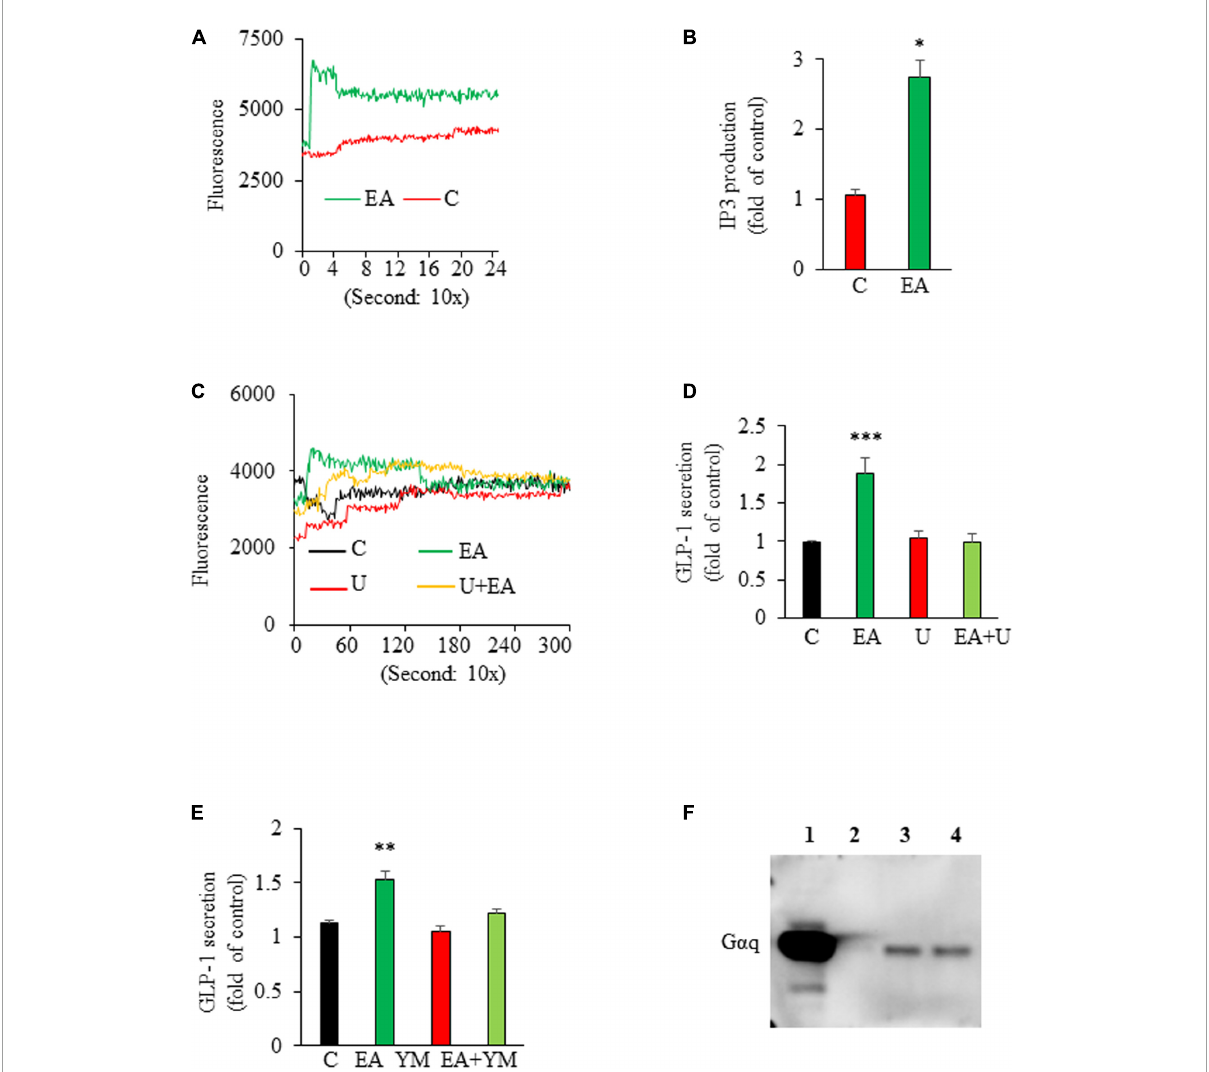
FIGURE2 Elenolic acid (EA)-induced glucagon-like peptide-1 (GLP-1) secretion is mediated via a G α q-PLC-IP3-Ca 2 + -dependent mechanism. (A) GLUTag L-cells were pretreated with Fluo-4AM and treated with vehicle or 10 µ M EA. The [Ca 2 + ] i response was measured using a fluorescence plate reader. A representative graph from 4 experiments is shown. (B) L-cells were treated with 10 µ M EA or vehicle for 20 s. The intracellular IP 3 contents were measured using an ELISA kit. (C) GLUTag cells were labeled with Fluo-4 AM in the presence or absence of 10 µ M U73122 (U) for 30 min, followed by an injection of 10 µ M EA or vehicle. The [Ca 2 + ] i response was measured as stated above. (D) GLUTag cells were pretreated with 10 µ M U73122 (U) for 30 min, followed by addition of 10 µ M EA or vehicle for another 1 h. Supernatants were collected for